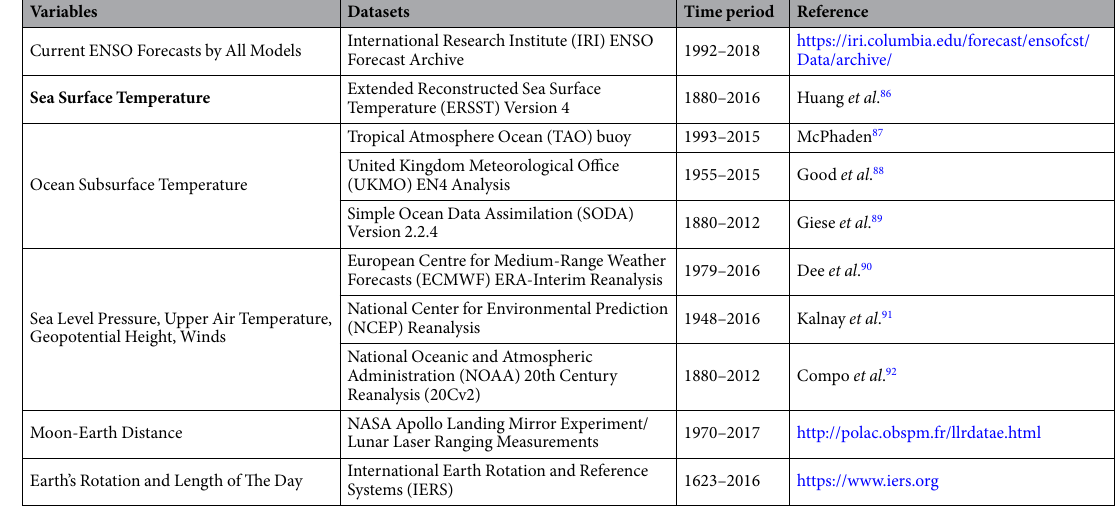
Table 1. Datasets used in this